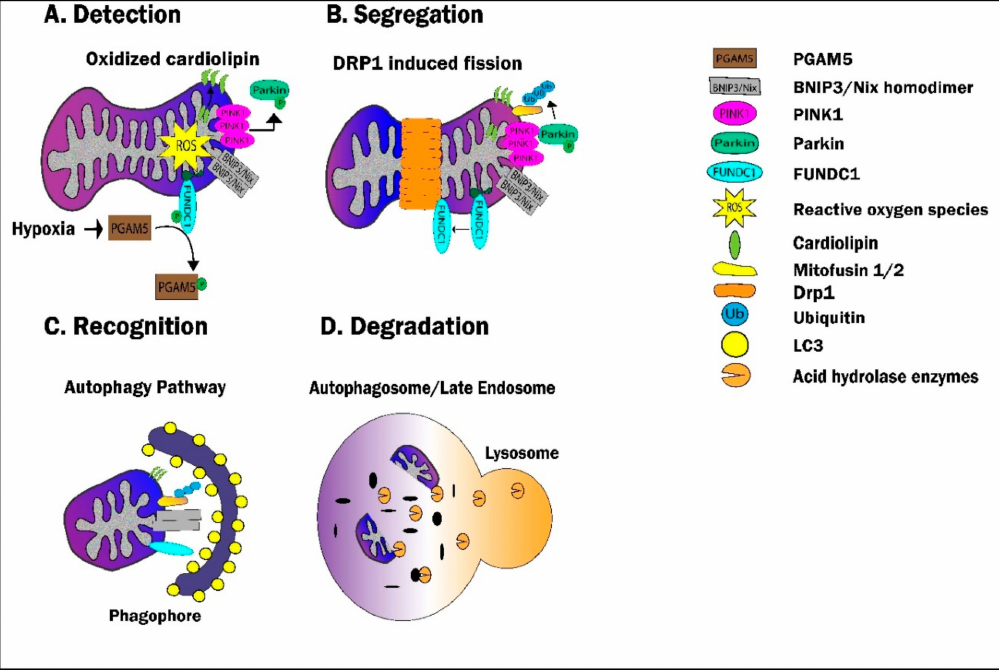
Figure 6. Mitophagic elimination of dysfunctional mitochondria during ischemia-reperfusion. Mitophagy is achieved via four distinct pathways: ( A ) Detection of dysfunctional mitochondria through PINK1 / Parkin recruitment, BNIP3 / Nix homodimerization / activation, FUNDC1 activation, and externalization of cardiolipin. ( B ) Segregation of dysfunctional mitochondria through DRP1-dependent fission and disruption of fusion machinery. ( C ) Recognition of the dysfunctional mitochondria via LC3-binding domain interactions with the phagophore. ( D ) Degradation of the sequestered mitochondria by acid hydrolase enzymes following lysosomal fusion. Dysfunctional mitochondrial segments are represented in blue, viable mitochondria represented in purple. PGAM5 = positive regulatorofFUNDC1; PINK1 = PTEN-inducedkinase; BNIP3 = Bcl-2adenovirusE1B19-kDa-interacting protein-3; Mfn 1 / 2 = Mitofusins 1 & 2; DRP1 = dynamin related protein-1; LC3 = light chain-3 protein; ROS = reactive oxygen